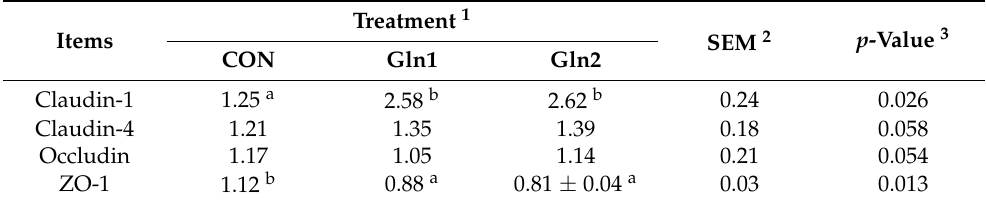
Table 7. Effects of adding Gln to high concentrate on the expression of tight junction protein gene in rumen epithelium of